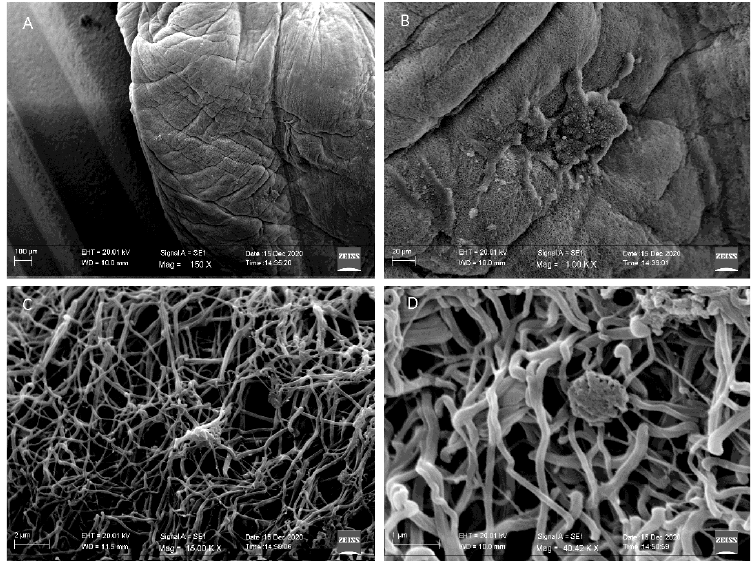
Figure 1. Scanning electron microscopy analysis of CGF-permeated implant. ( A ) CGF was able to adhere to the implant surface almost completely. ( B , C ) CGF fibrin forming a dense network con- teining few corpuscular elements. ( D ) A corpuscular element entangled in the fibrin network.